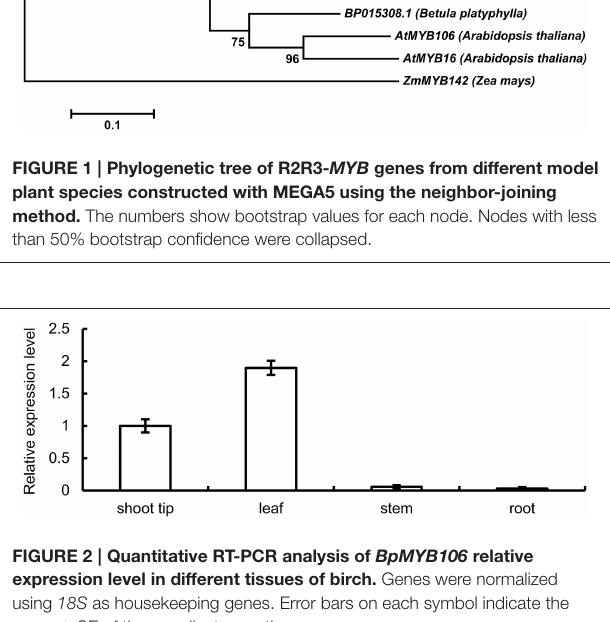
the leaves and shoot tips, and lowest in stem and root tissues ( Figure 2